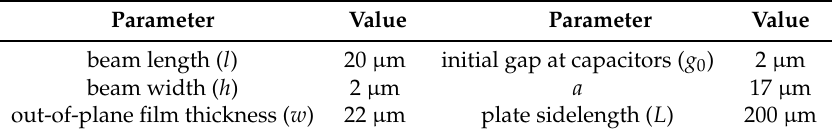
Table 1. Geometric dimensions of the